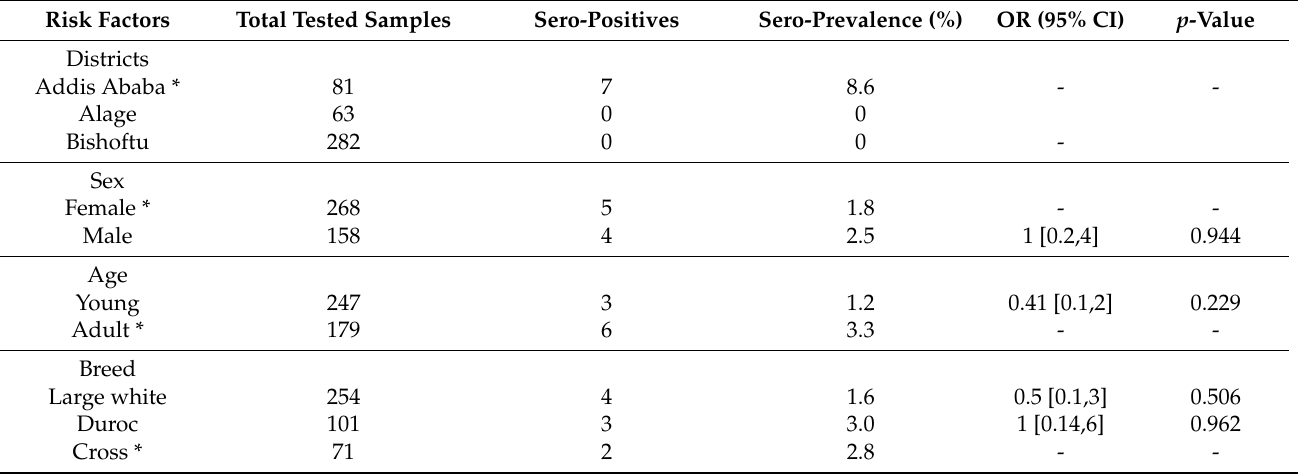
Table 6. Factors associated with FMD sero-positivity using multivaraible logistic regression analysis in swine ( N = 426).